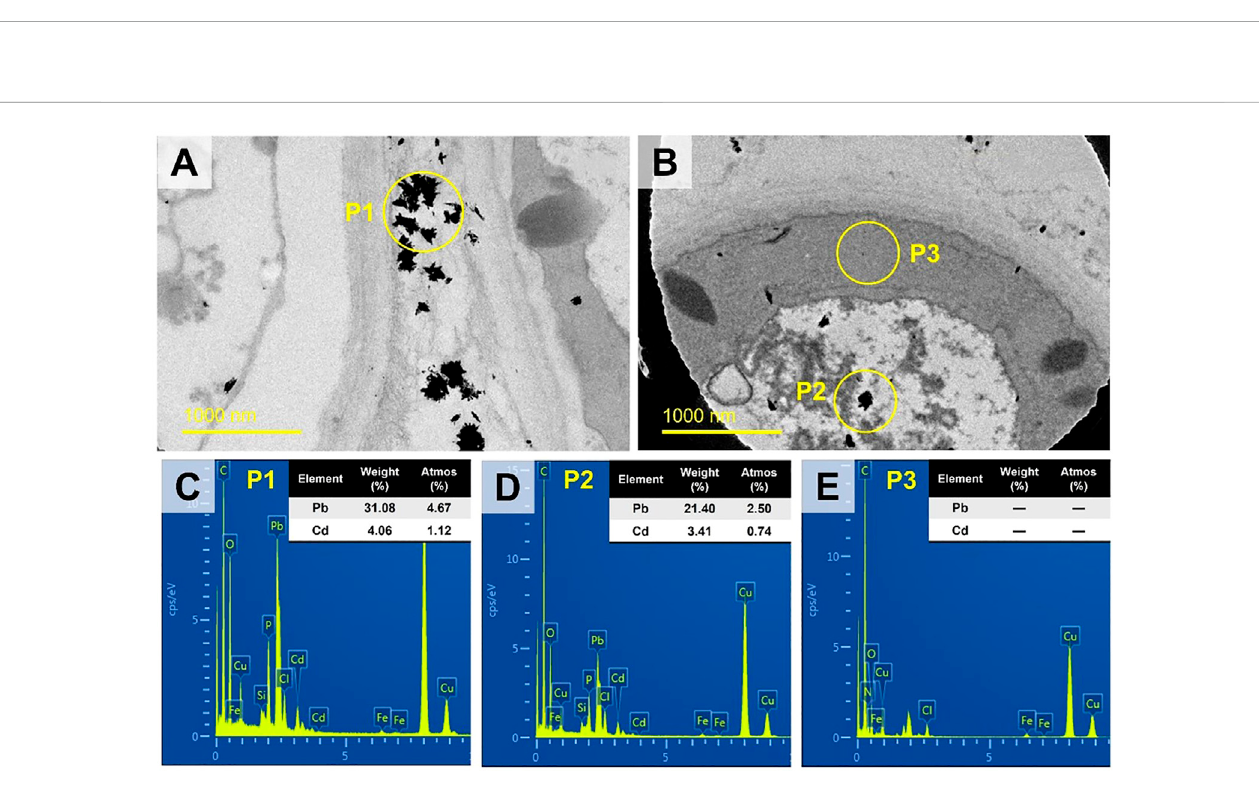
The TEM images of the rectangular regions in Figures 4A image (A) and 4C image (B) at high-resolution (slight offset might occur). Three representative spots (P1, P2, P3) were selected for EDS analysis as shown in images (C – E)